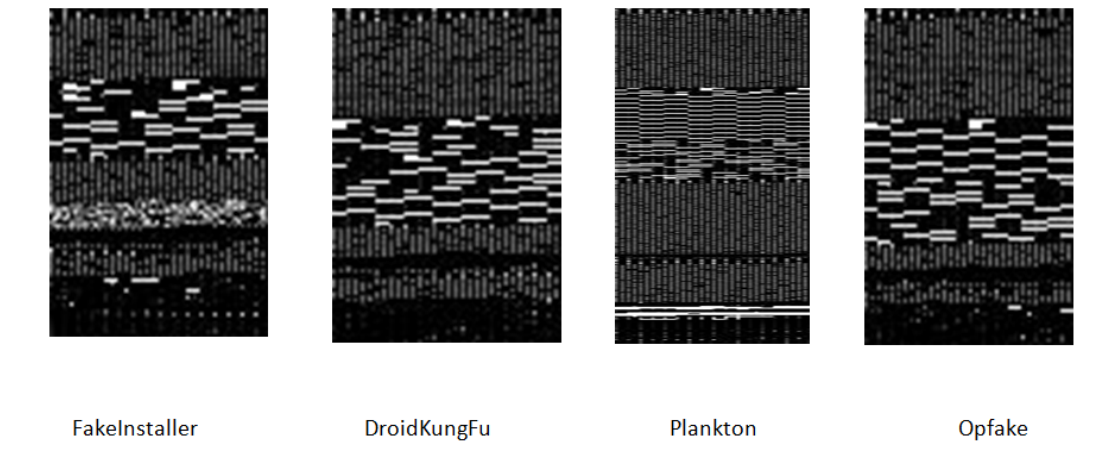
Figure 5. The fingerprint images of different malware family using file sections of Android manifest (AM) and resource (RS) of an APK